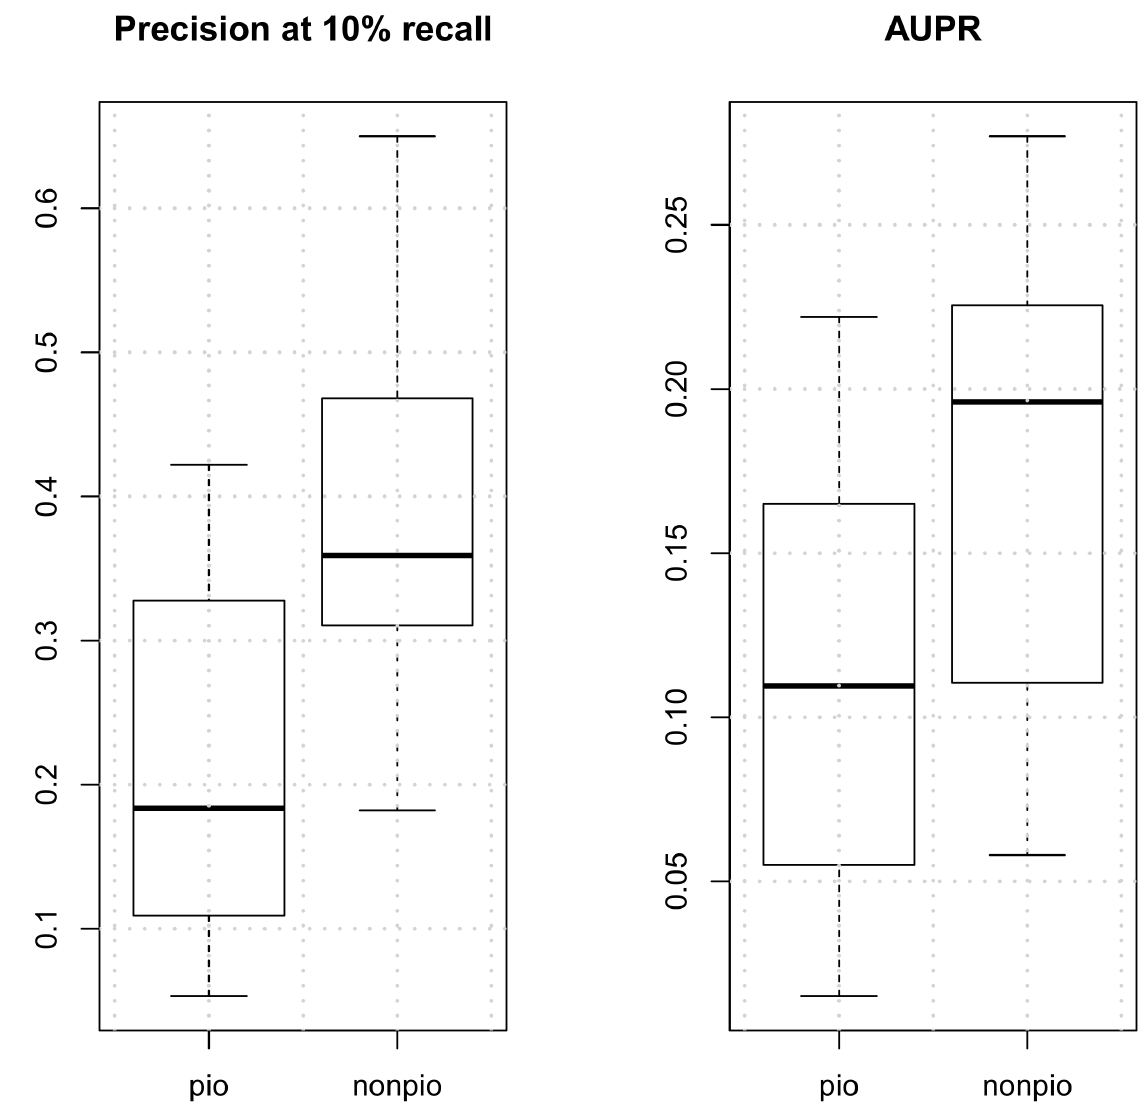
Fig 2. Comparison of prediction performance for pioneer class factors and non-pioneer (settler and migrant) class factors.